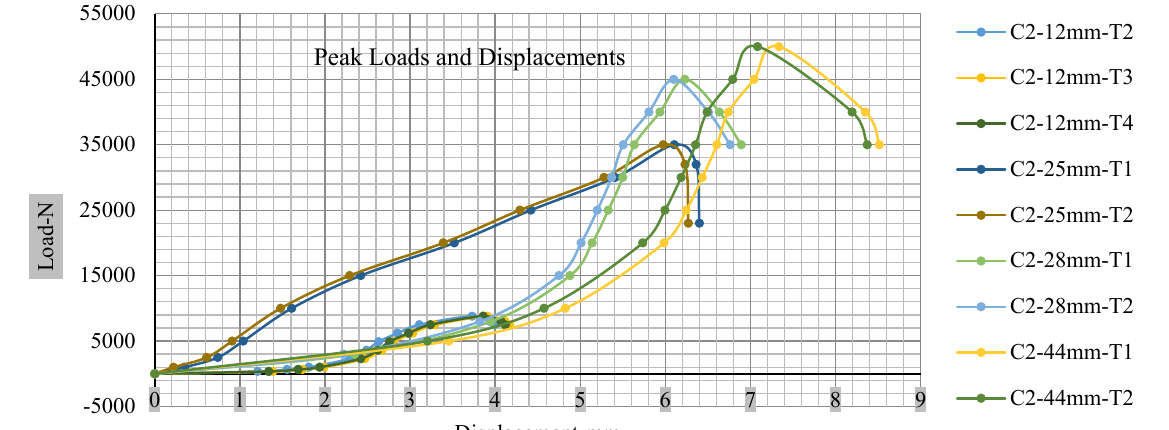
Figure 19. Cell 2 peak loads and displacements.